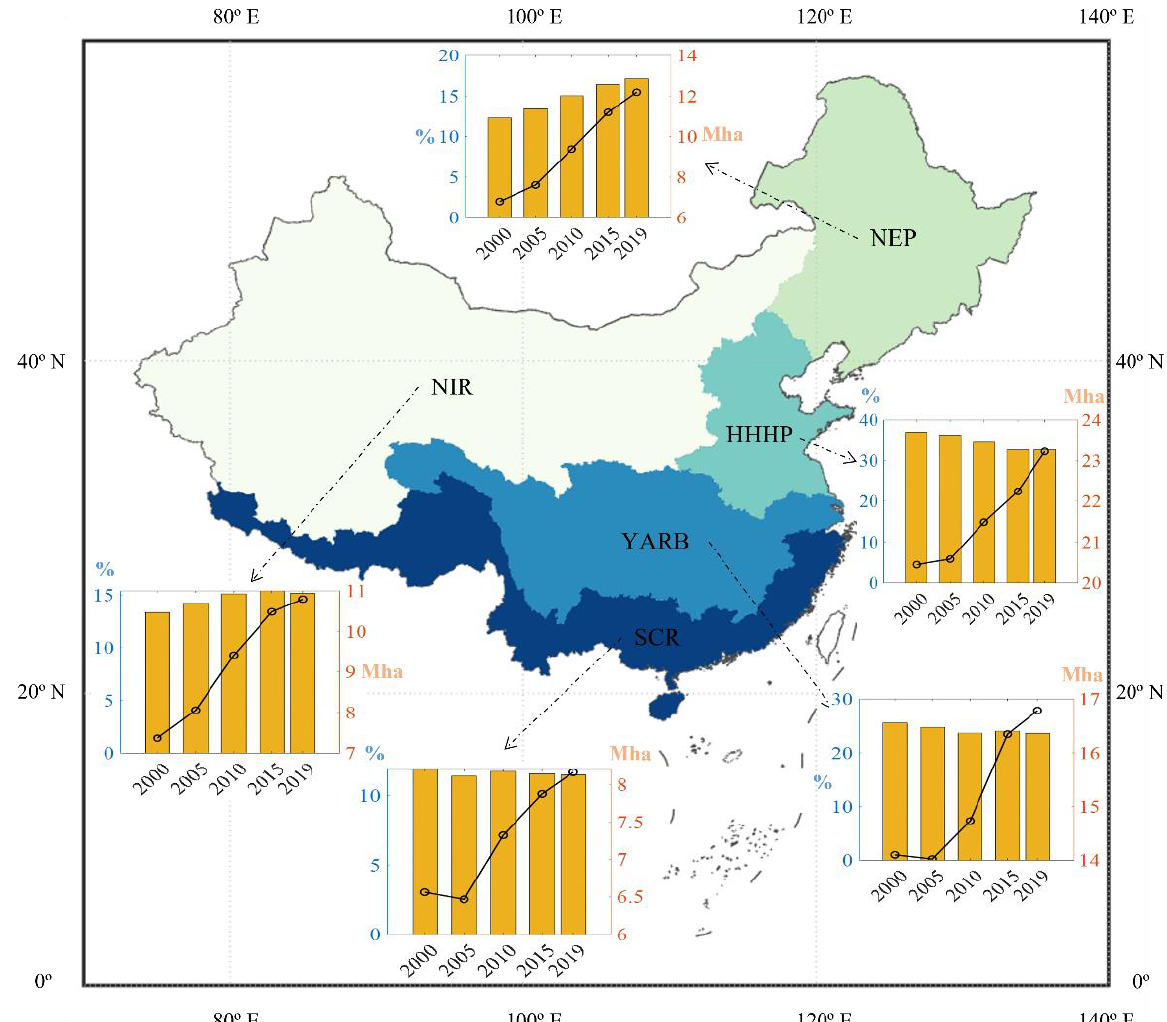
Figure 7. Changes in regional irrigated areas and their proportion from 2000 to 2019.